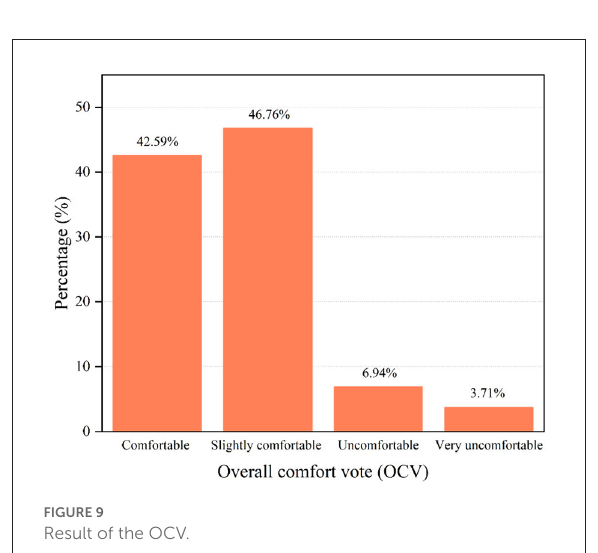
FIGURE9 Result of the OCV.